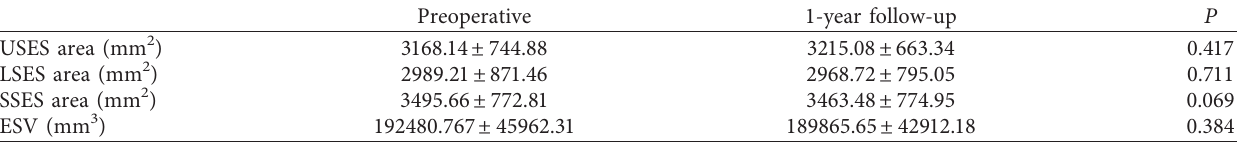
Table 3: Preoperative and postoperative paraspinal muscle